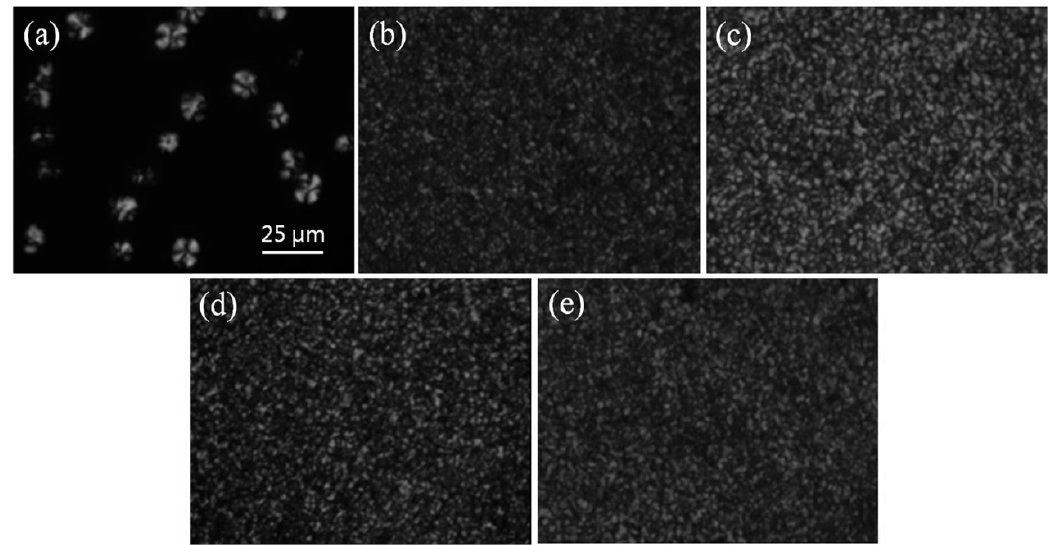
Figure 11. Spherulitic morphologies of ( a ) PEEK, ( b ) PEEKC1, ( c ) PEEKC1M1, ( d ) PEEKC1M2, and ( e ) PEEKC1M4 isothermally crystallized at 320 °C for 15 min from the melt.